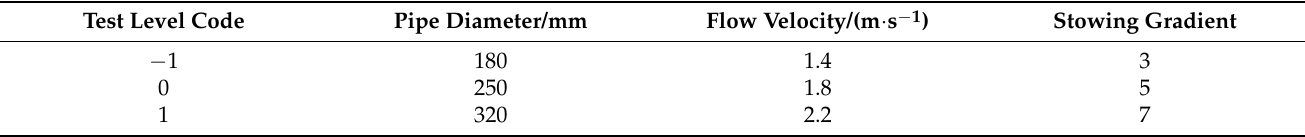
Table 8. Exogenous factor parameters and level codes.